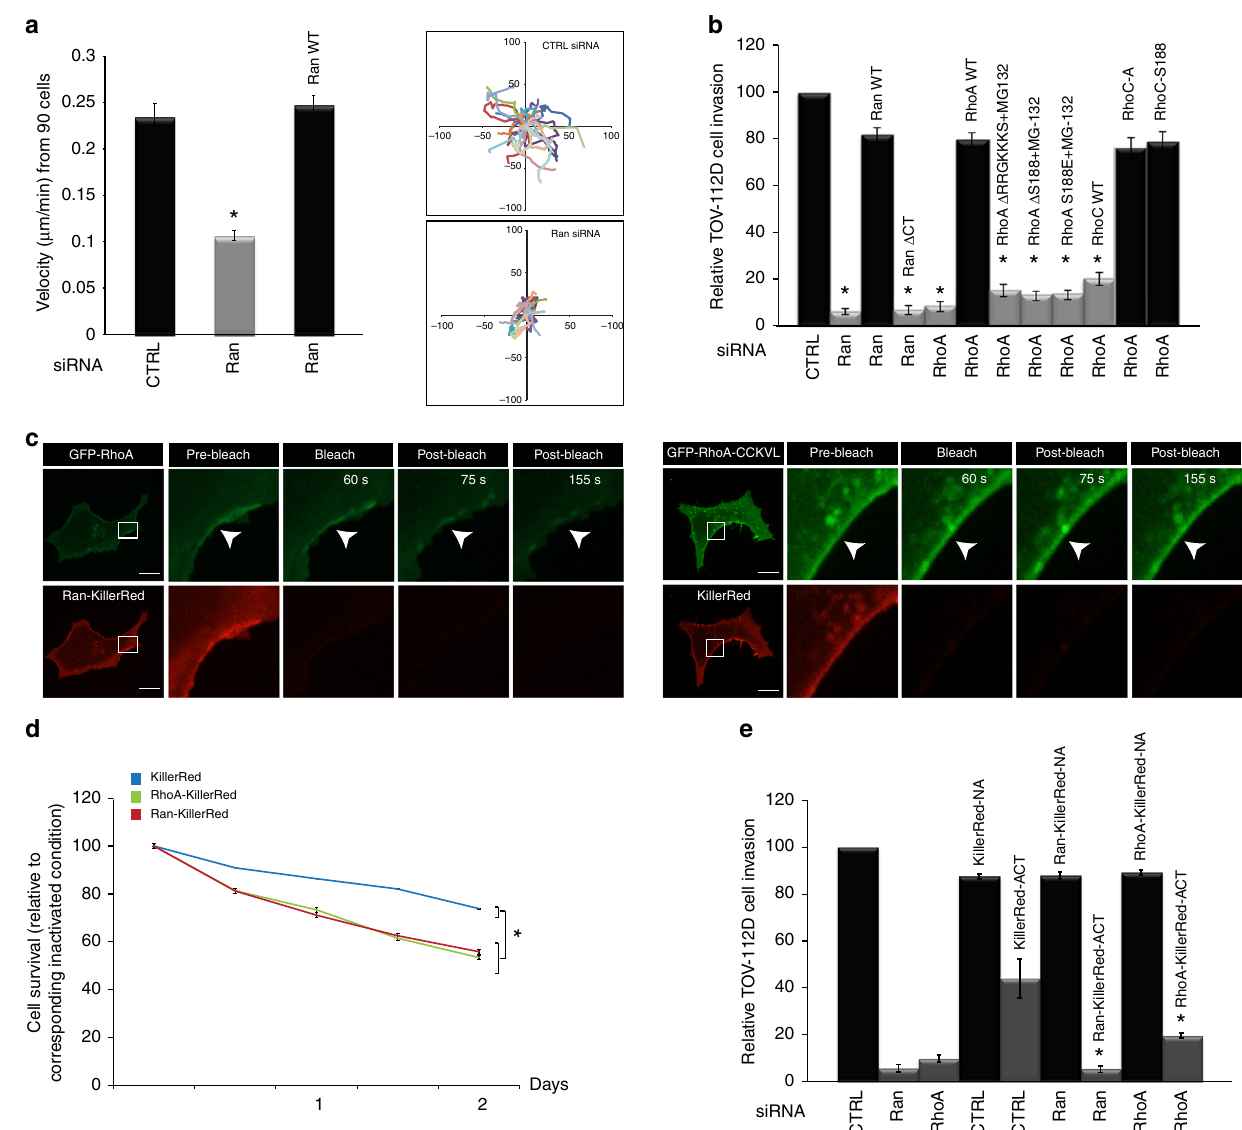
Fig. 5 Ran regulates cell proliferation and migration/invasion through RhoA recruitment. a TOV-112D cells were transfected with siRNAs, and Ran WT as indicated for cell migration assays. Left, cell velocity was determined by tracking living cells. Right, analysis of cell migration paths in CTRL and Ran KD cells. The data represent the trajectories of 30 cells. All values are means ± SEM from three independent experiments. P -values are based on comparisons with CTRL using the t test: * P < 0.05 was considered statistically signi fi cant. b Effect of Ran-RhoA signaling with or without MG-132 treatment on transwell cell invasion. The invading TOV-112D cells passed through the membrane and were fi xed, stained, quanti fi ed as described in the Methods section. All values are means± SEM from three independent experiments. P -values are based on comparisons with CTRL using the t test: * P < 0.05 was considered statistically signi fi cant. c Left, TOV-112D cells co-expressing Ran-KillerRed and GFP-RhoA were irradiated with green light for 60 s. The illumination resulted in considerable decrease in GFP membrane signal (arrowheads) con fi rming RhoA detachment from the plasma membrane after light-induced damage of Ran. Right, control experiment showing TOV-112D cells co-expressing KillerRed and GFP-RhoA-CCKVL were irradiated with green light for 60 s. No change in GFP signal distribution from the plasma membrane was observed. Scale bars, 10 µ m. d Graph shows TOV-112D cell proliferation plotted over time (from the third day post transfection) for each condition as indicated and normalized with corresponding inactivated condition. Values (means ± SEM) from three independent experiments are shown as ratio change in cell survival. P -values are based on comparisons with CTRL using the t test: * P < 0.05 was considered statistically signi fi cant. e Transwell-invasion assay using transwell chamber before and after KillerRed inactivation. NA non-activated, ACT activated. The data from three independent experiments are expressed as percent change (means ± SEM) compared with the controls. P -values based in comparison with KillerRed alone activated conditions using the t test: * P < 0.05 was considered statistically signi fi